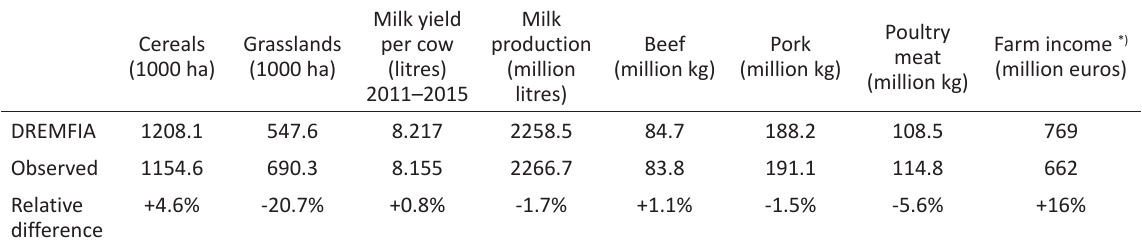
Table 2. Production quantities, crop cultivation areas and farm income in the baseline and in reality (“observed”: official agricultural statistics, http://www.luke.fi/en/statistics/ ); 5-year average for the 2012–2016 period. The grassland area is smaller in the DREMFIA baseline than in reality, since horses, lambs and reindeer (users of roughage) are not